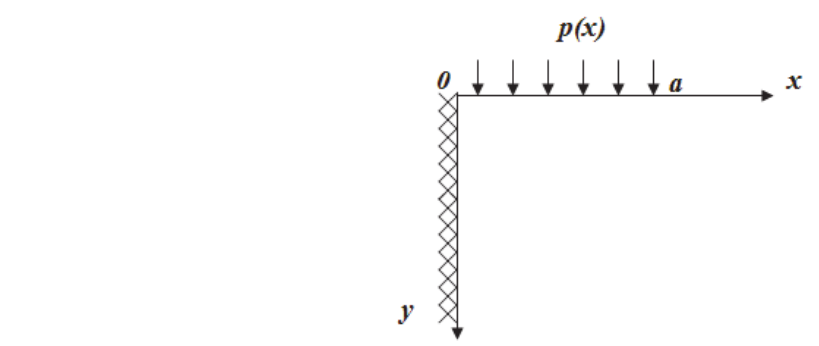
Figure 5: Geometry and coordinate system of the quarter